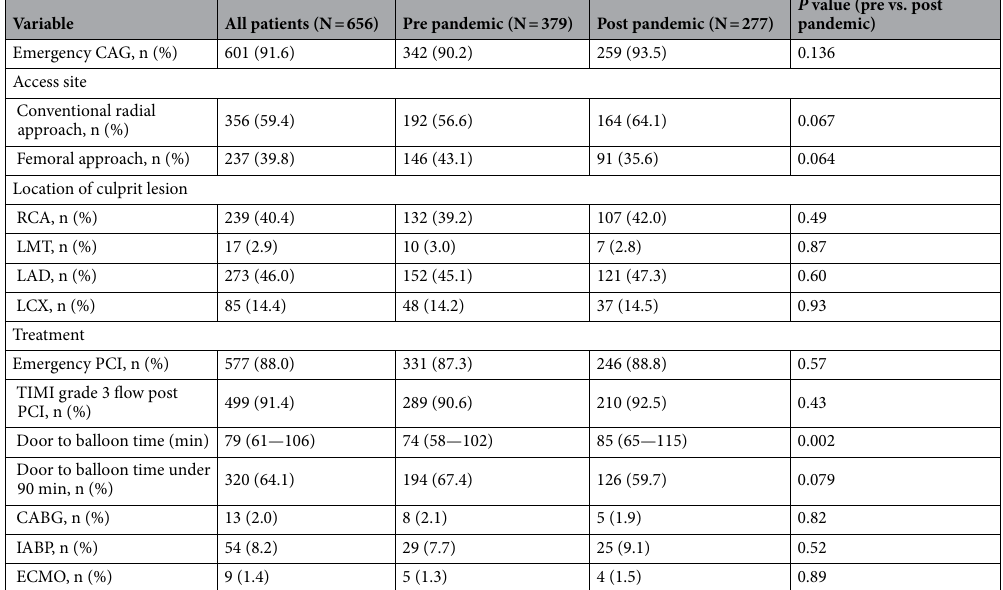
Table 2. Angiographic findings and invasive procedures. Continuous variables are presented as median (interquartile range). Categorial variables are presented as number of patients (%). CABG coronary artery bypass grafting, CAG coronary angiography, ECMO extra-corporeal membrane oxygenation, IABP intra-aortic balloon pumping, LAD left anterior descending artery, LCX left circumflex artery, LMT left main coronary trunk, PCI percutaneous coronary intervention, RCA right coronary artery, TIMI thrombolysis in myocardial